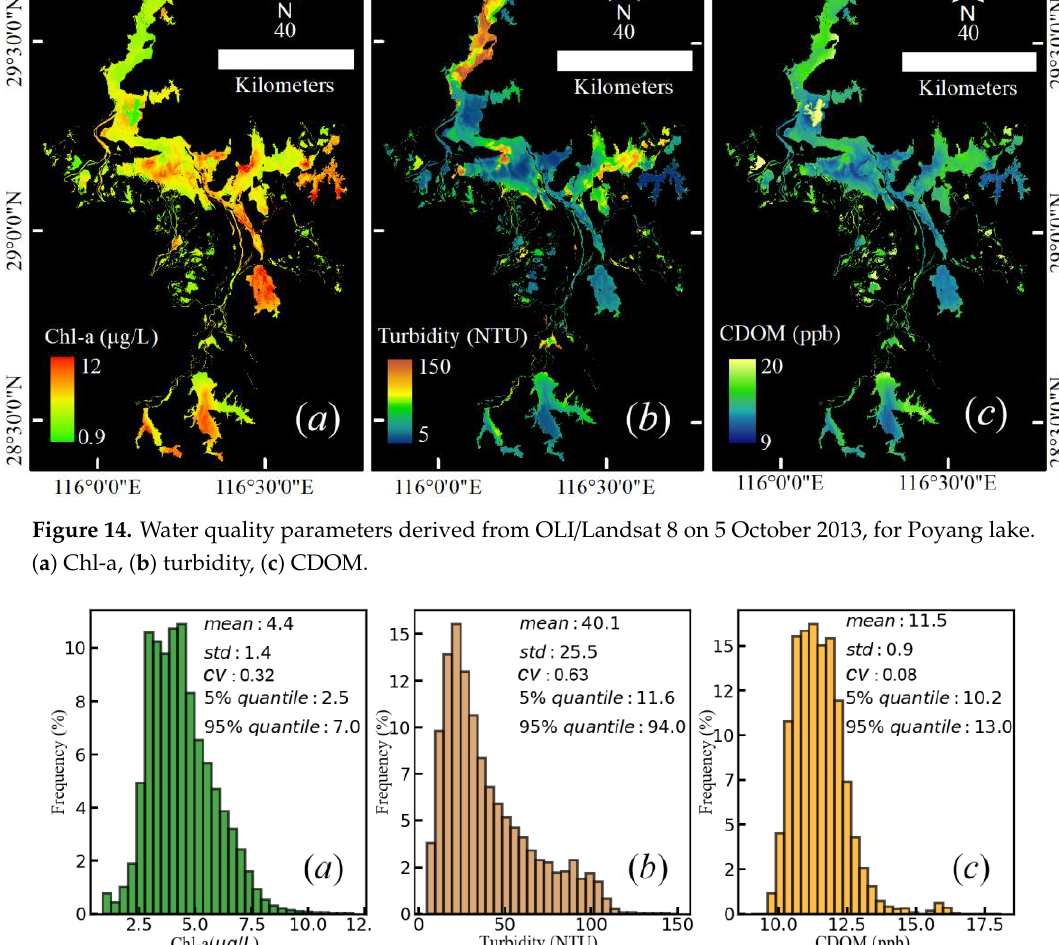
Figure 14. Water quality parameters derived from OLI/Landsat 8 on October 5, 2013, for Poyang lake.